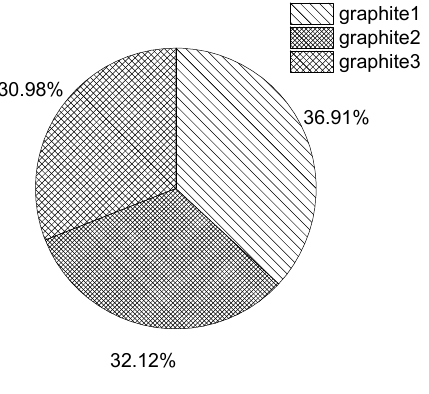
Figure 14. Wear ratio.